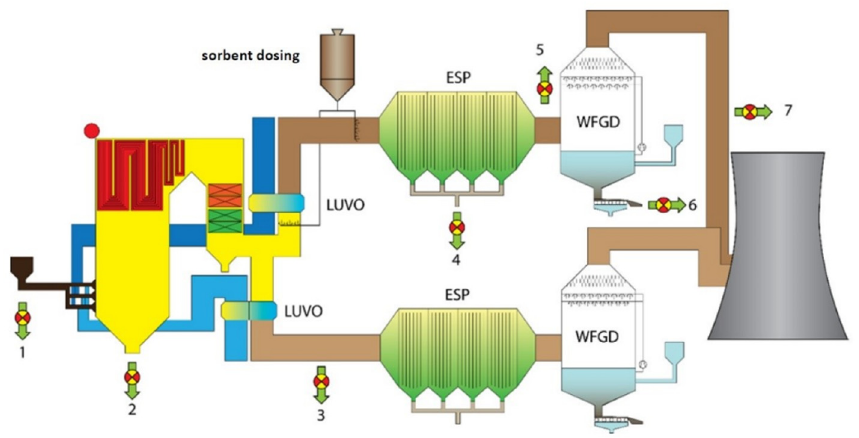
Figure 2. Scheme of installation applying organic sorbents—industrial tests: 1—sample of coal, 2—sample of slag, 3—raw exhaust gas downstream the rotary air heater and upstream of the ESP on the line where no sorbents were dosed, 4—sample of fly ashes from the line where sorbents were dosed, 5—flue gases after ESP and before WFGD in the line where sorbents were dosed, 6—a sample of gypsum from the line where sorbents were dosed, and 7—flue gases treated in the line where sorbents were dosed.